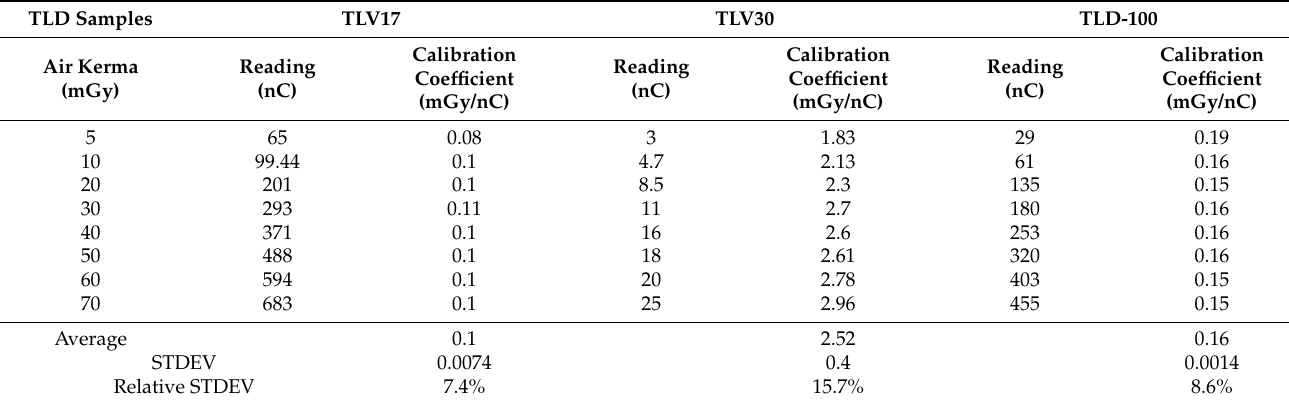
Figure 6. ( a – c ) The glow curves for the TLD samples without a radition dose. Table 2. TL dose results from 137 Cs irradiation from